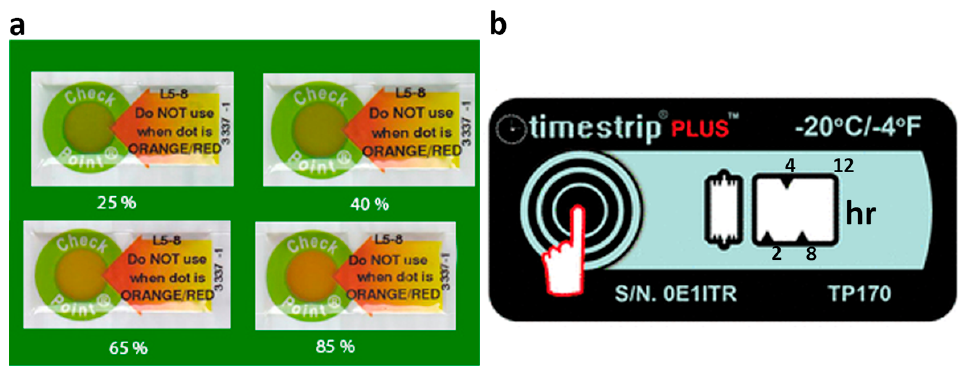
Figure 4. ( a ) Critical temperature sensing system based on an enzymatic reaction and capable of indicating if a product has been compromised. ( b ) Critical time–temperature sensing system that indicates how long a breach of the threshold temperature has occurred. Adapted with permission from [7]. Copyright © 2019 American Chemical Society.